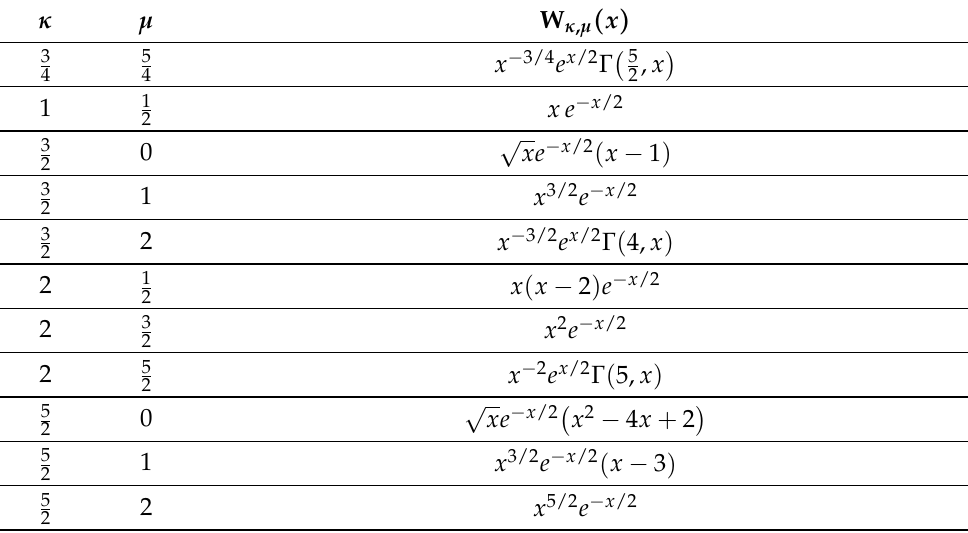
Table A11. The Whittaker functions W κ , µ derived for some values of parameters κ and µ by using